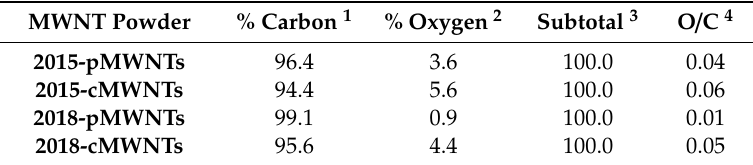
Table 5. XPS elemental analyses of pMWNT and cMWNT